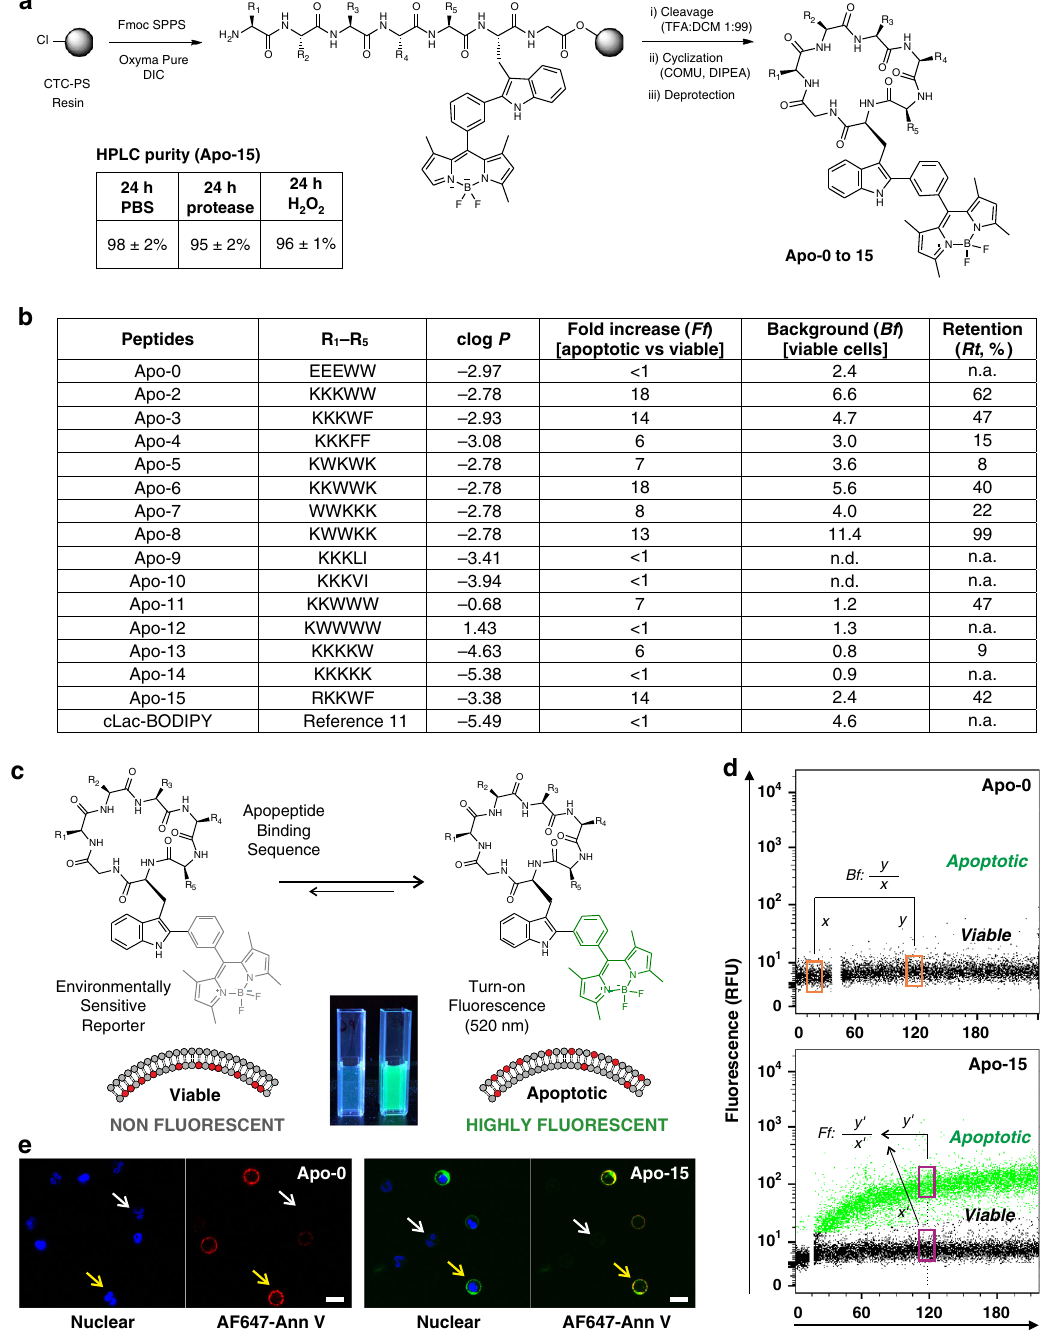
incubation with Apo-0 (left, green) and Apo-15 (right, green) (both at 100 nM). Cells were co-stained with Hoechst 33342 (7 μ M, blue) and AF647- Annexin V (5 nM, red) as nuclei and apoptosis markers, respectively ( λ exc. : 405, 488, 633 nm: λ em. : 450, 525, 670 nm). Scale bars: 10 μ m. Source data (in b ) are provided as a Source data fi